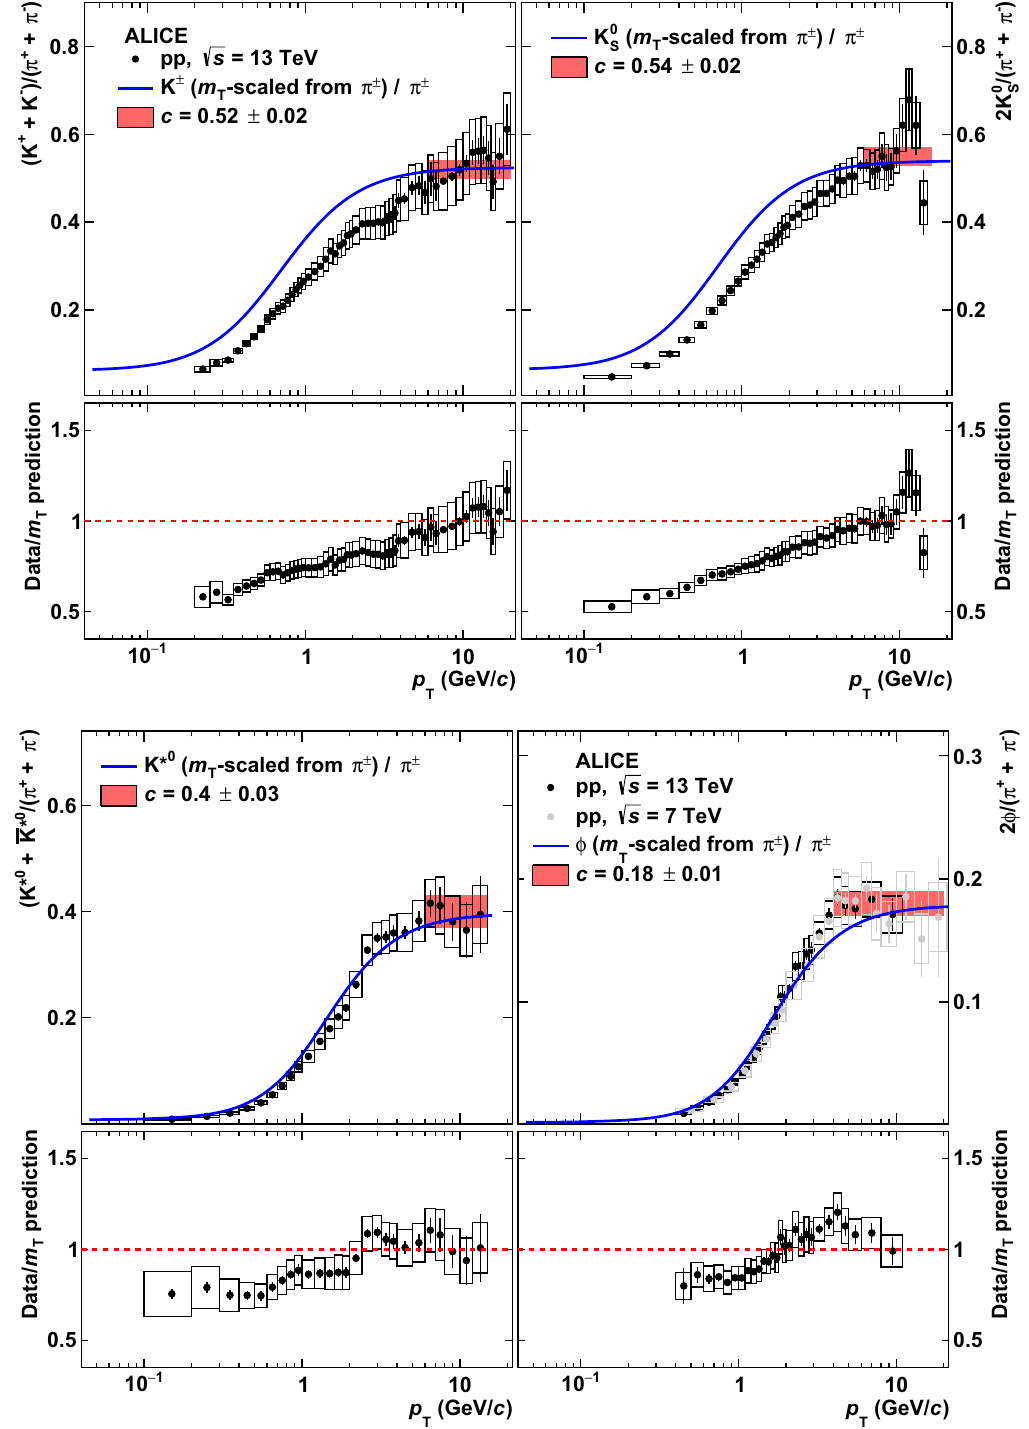
Fig. 8 Particle ratios K ± / π ± , K 0 / π ± (top) and K ∗ 0 / π ± , φ / π ± (bot- shaded red band indicates the constant fit, in the p T region where it was √ S s = 13 TeV. tom) as a function of p T measured in pp collisions at performed, which is used to determine the constant offset parameter c . See the text for details. The φ spectrum in pp at The measured ratio is reported together with that obtained from trans- verse mass ( m T ) scaling of charged pions shown as a solid line. The Ref.